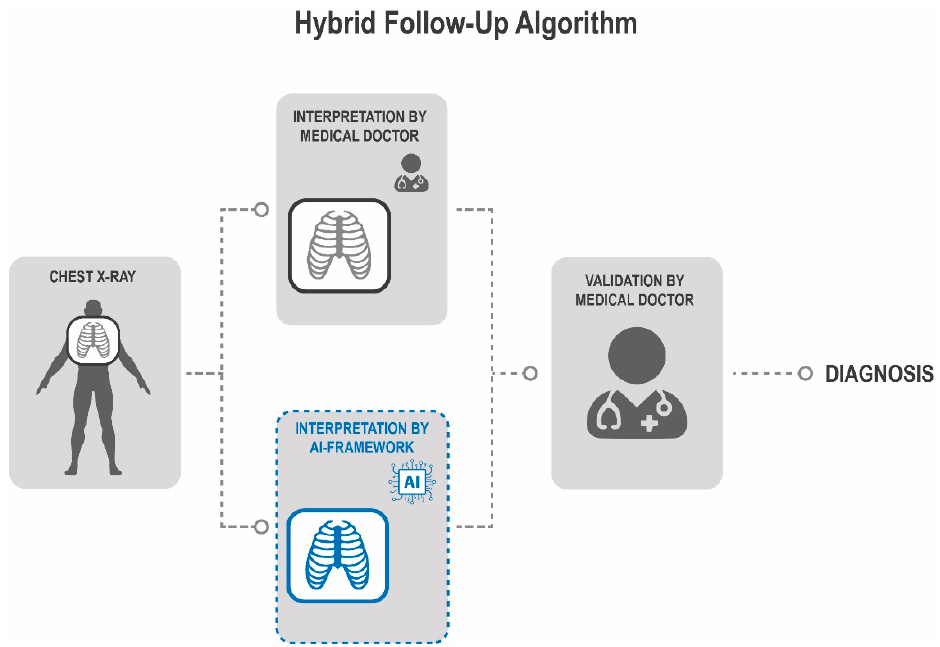
Figure 6. Hybrid Follow-Up Algorithm. In order to improve our follow-up, the AI-based evaluation of the X-ray is placed parallel to the radiological assessment to avoid any bias. The information from both interpretations are validated by an independent second medical doctor.